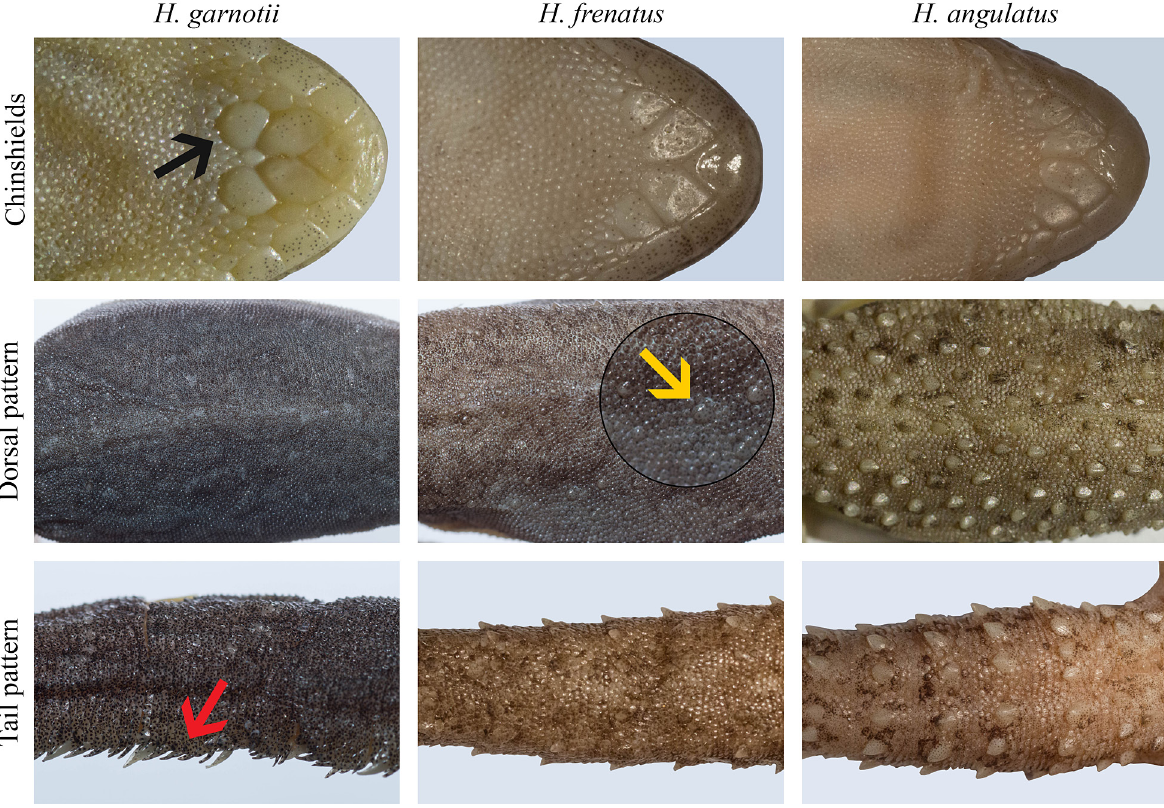
Figure 2. Morphological differences among Hemidactylus garnotii (MHUA-R 11124), H. frenatus (MHUA-R 11485), and H. angulatus (MHUA-R 10966) (chin shields, and dorsal and caudal scale arrangements). Black arrow: second pair of chin shields not in contact with infralabials in H. garnotii ; yellow arrow: dorsal flat tubercles in H. frenatus ; red arrow: serrated tail margin in H. garnotii .